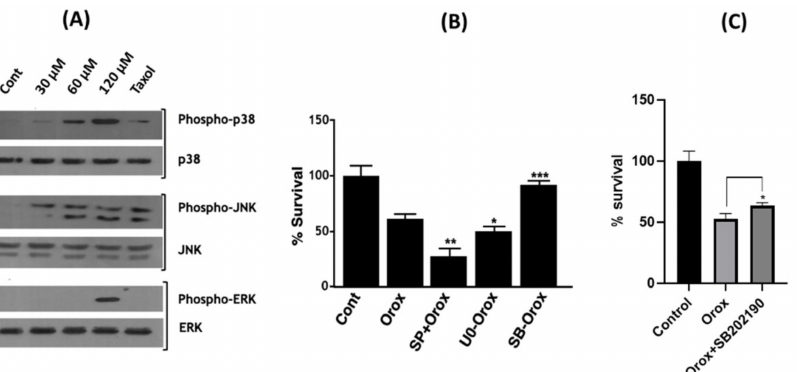
Figure 10. Oroxyquinone induces apoptosis via MARKs pathways. ( A ) PC3 cells were cultured and treated with different doses of oroxyquinone; the total proteins were extracted and separated by SDS-PAGE, and were immunoblotted using antibodies against total and phosphorylated forms of p38, JNK, and ERK. ( B ) PC3 cells were cultured and treated with the specific inhibitors SP600125 (SP), U0126 (U0), and SB203580 (SB) for JNK, ERK, and p38, respectively, for 24 h, and MTT assays were performed. ( C ) The involvement of p38 in apoptosis in PC3 cells treated with oroxyquinone was revalidated using p38 inhibitor SB202190. The p -value was calculated by comparison to the oroxyquinone-treated cells using Student’s “ t ” test. The bars indicate SD, * indicates a p -value > 0.05, ** indicates a p -value > 0.01, and *** indicates a p -value >